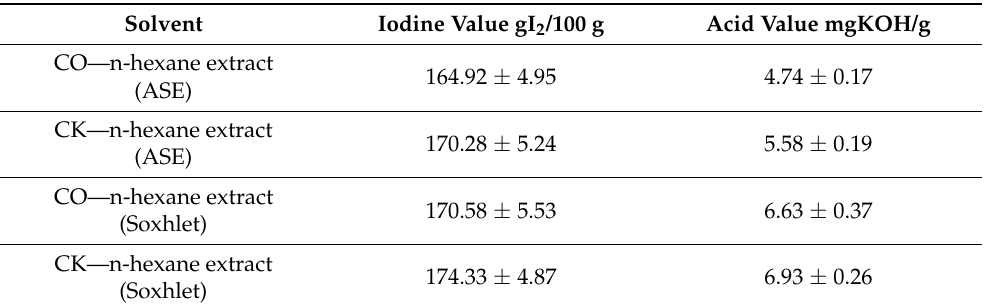
Table 1. Iodine values and acid value characteristics of n-hexane extracts of CK and CO spent coffee grounds were obtained using ASE and Soxhlet extraction.